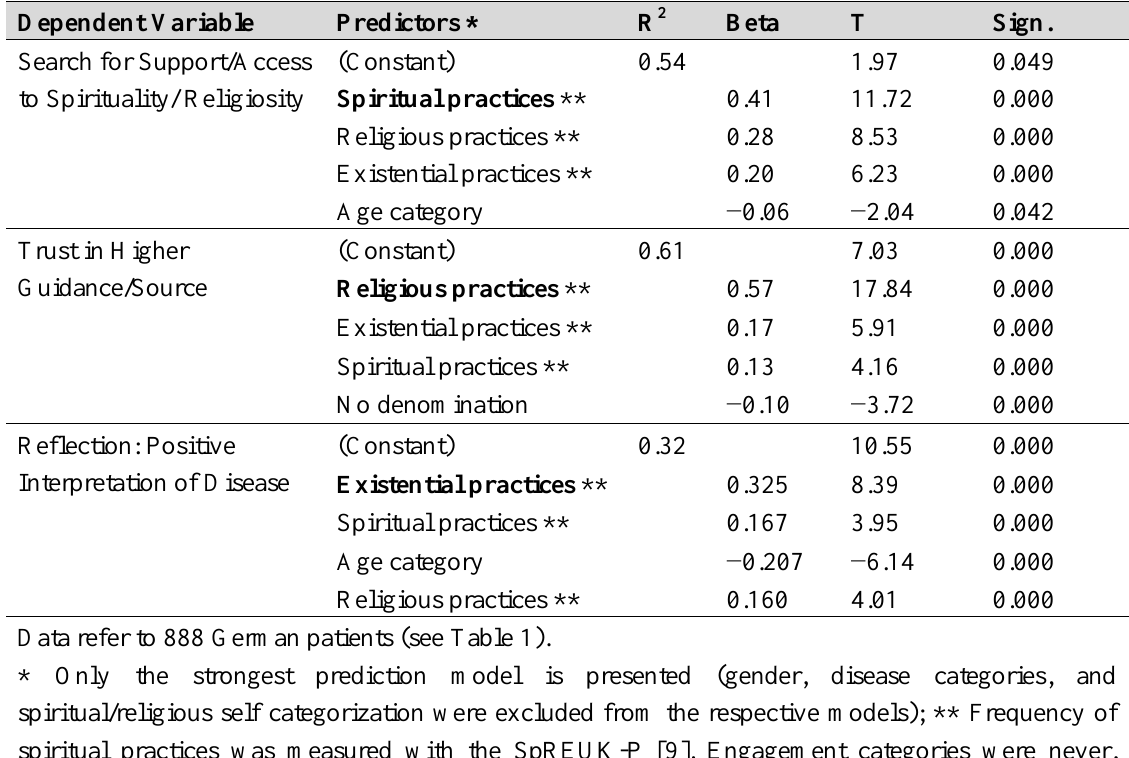
Table 4. Predictor analysis (stepwise regression